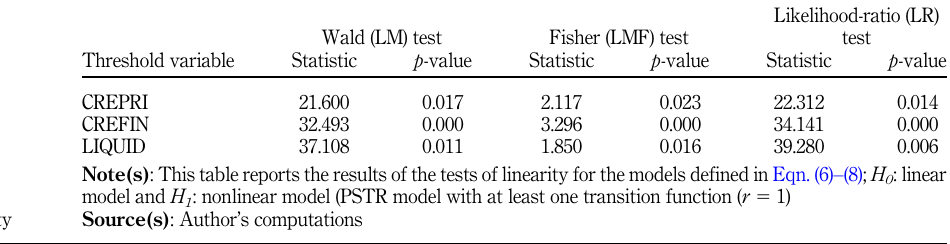
Table 1. Test of linearity